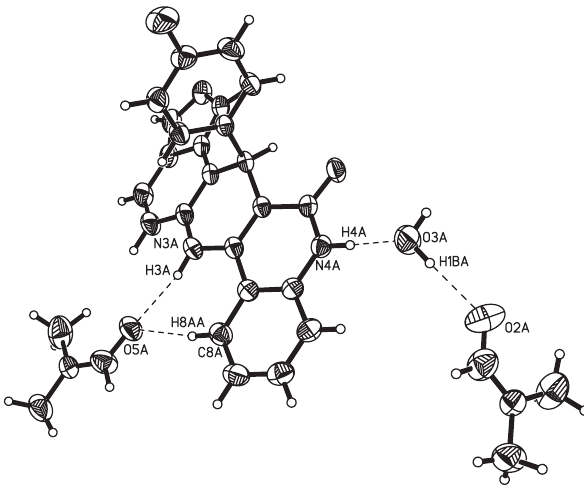
Figure 2: The hydrogen bonds between target molecule and solvent